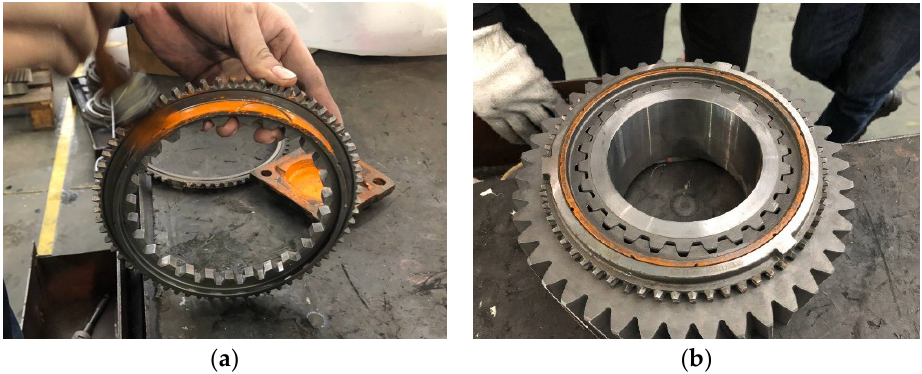
Figure 15. Color lead powder detection method. ( a ) smearing; ( b ) rotating and matching.